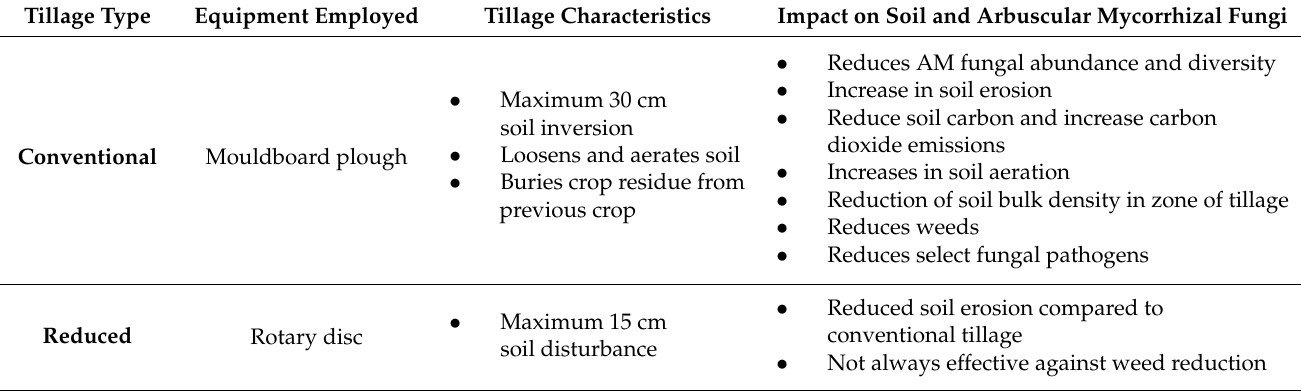
Table 1. Summary of select tillage types and their associated mechanical impact characteristics upon soils and arbuscular mycorrhizal (AM) fungi